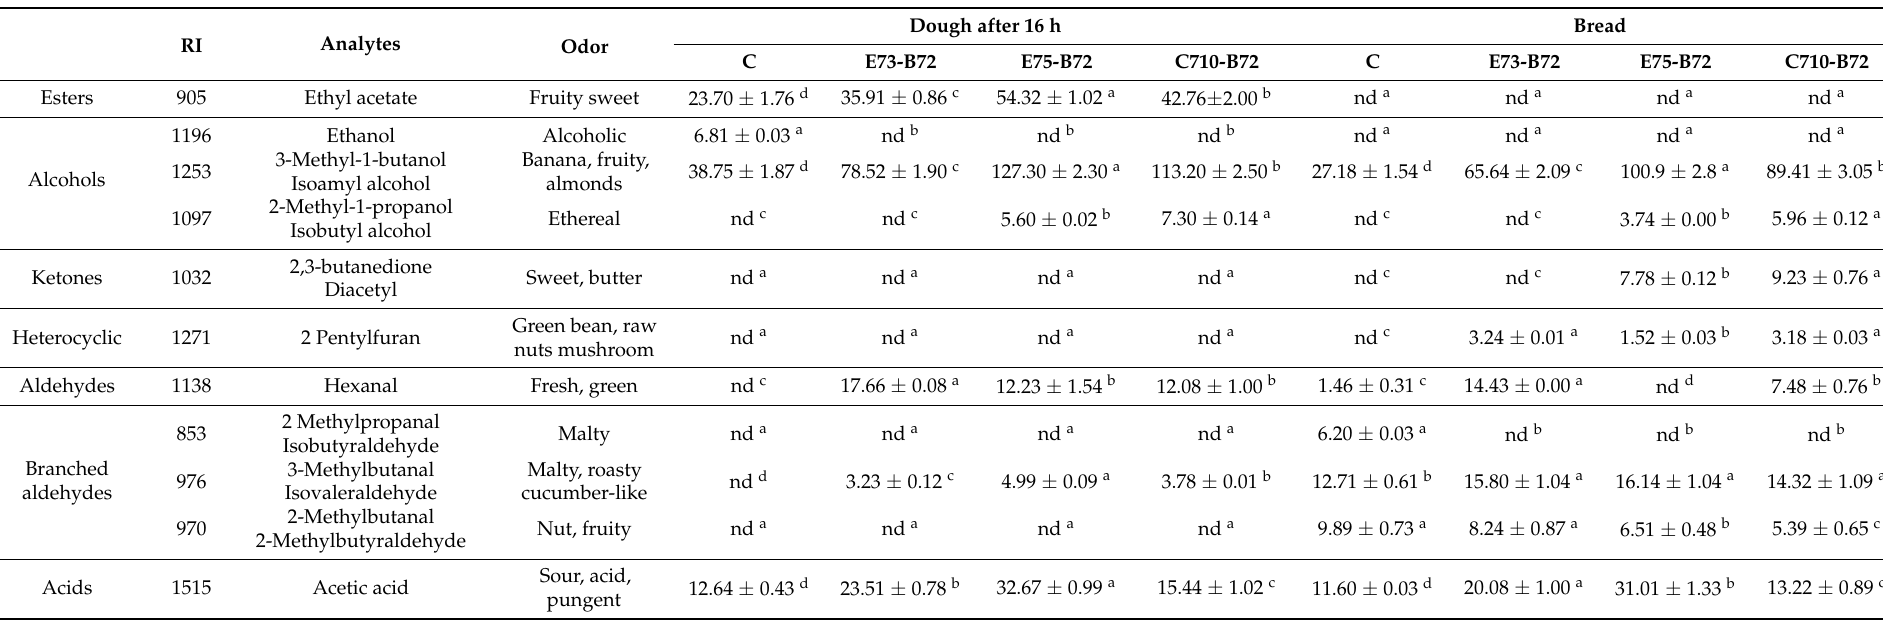
Table 2. VOCs (mg/g) detected in doughs at time zero, sourdough after 16 h of fermentation, and bread samples. Only VOCs detected at a concentration higher than 0.5 mg/g are reported as mean values ± SD. Different superscript letters in a row indicate statistically significant differences (ANOVA: Tukey t -test. p < 0.05.